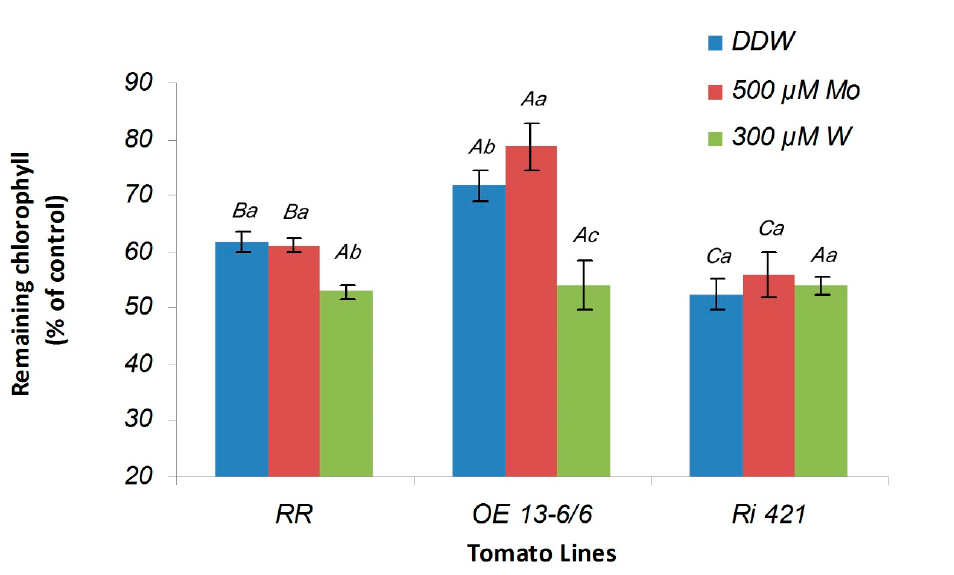
Figure 8. Effect of molybdenum, tungsten and DDW pretreatment on the remaining chlorophyll content in leaf discs after sulfite treatment. Leaves from wild type (RR), SO OE (OE 13-6/6) and SO Ri (Ri 421) tomato lines were incubated in DDW, 500 µM Mo or 300 µM W for 24 h. Leaf discs were subjected to 0 mM and 7 mM Na 2 SO 3 for 24 h. The remaining chlorophyll was expressed in percent of control. Values are the mean ± SE ( n = 7). Different letters show significant differences, p < 0.05. Upper case letters represent the effect between tomato lines and the lower case letters represent the effect between pretreatments within the line.